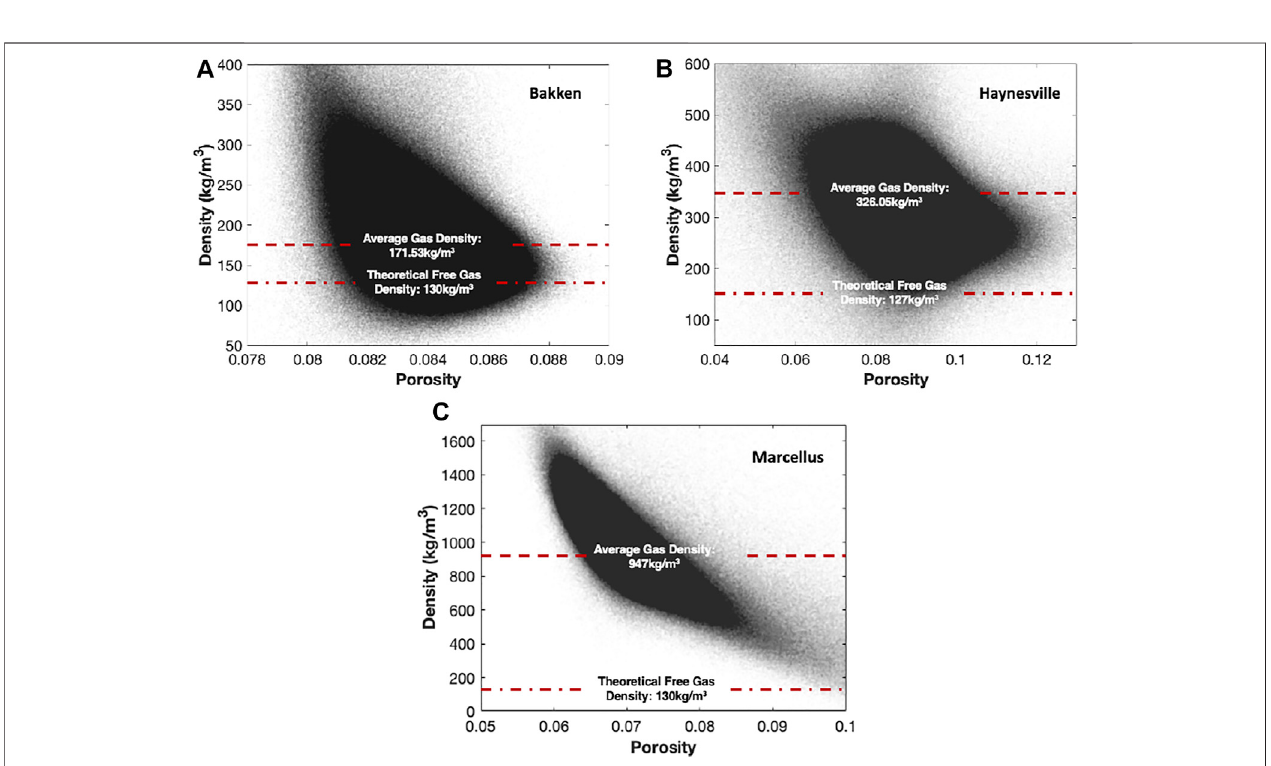
Frontiers in Earth Science |